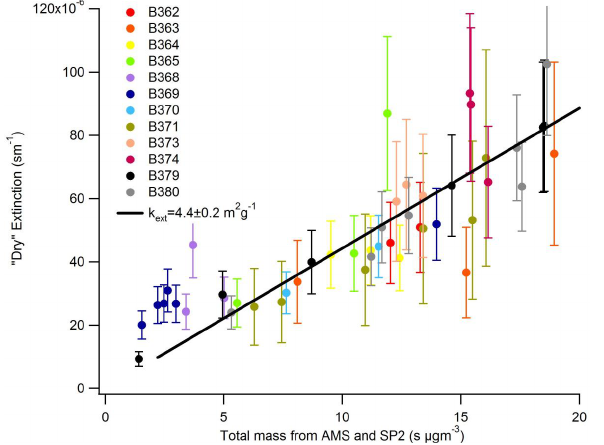
Figure 2 Aerosol extinction at 550nm as calculated as the total of scattering measured by the 3 Fig. 2. Aerosol extinction at 550nm as calculated as the total of nephelometer and absorption measured by PSAP as a function of total aerosol mass (from 4 scattering measured by the nephelometer and absorption measured total of Aerosol Mass Spectrometer and SP2 instrument). Error bars are uncertainty as 5 by PSAP as a function of total aerosol mass (from total of Aerosol calculated from measurement errors and in-run variability of scattering and absorption (one 6 Mass Spectrometer and SP2 instrument). Error bars are uncertainty standard deviation) for each individual run. Solid line represents a mass extinction 7 as calculated from measurement errors and in-run variability of relationship of 4.4±0.2 m 2 g -1 (uncertainty is the average residual from the best-fit line). All 8 scattering and absorption (one standard deviation) for each indi- quantities reported at standard temperature and Pressure (STP). 9 vidual run. Solid line represents a mass extinction relationship of 4.4±0.2m 2 g − 1 (uncertainty is the average residual from the best- fit line). All quantities reported at standard temperature and Pressure (STP).